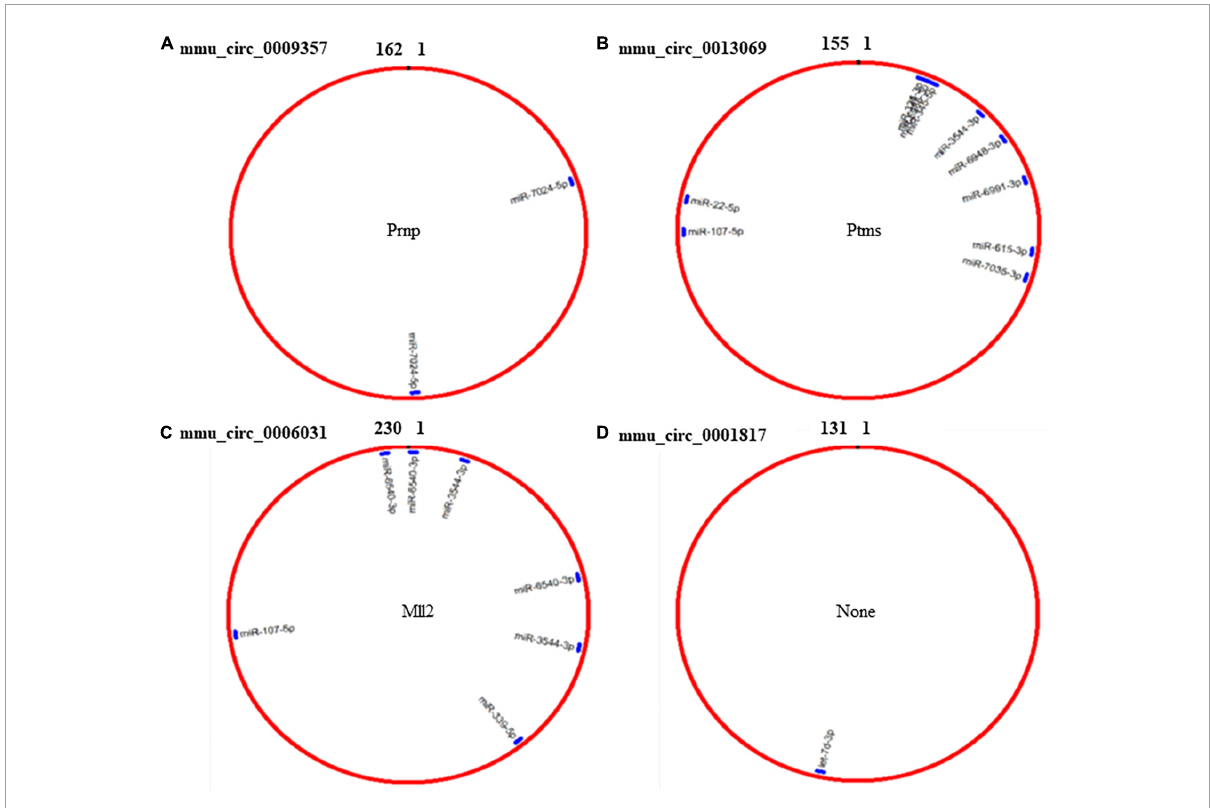
FIGURE4 Prediction of miRNAs that interact with mmu_circ_0009357, mmu_circ_0013069, mmu_circ_0006031, and mmu_circ_0001817 by circMIR software. (A) Predicted binding site for miR-7024-5p on mmu_circ_0009357. (B) Combination site for 10 miRNAs on mmu_circ_0013069. (C) Predicted binding site for four miRNAs on mmu_circ_0006031. (D) Predicted binding site for let-7d-3p on